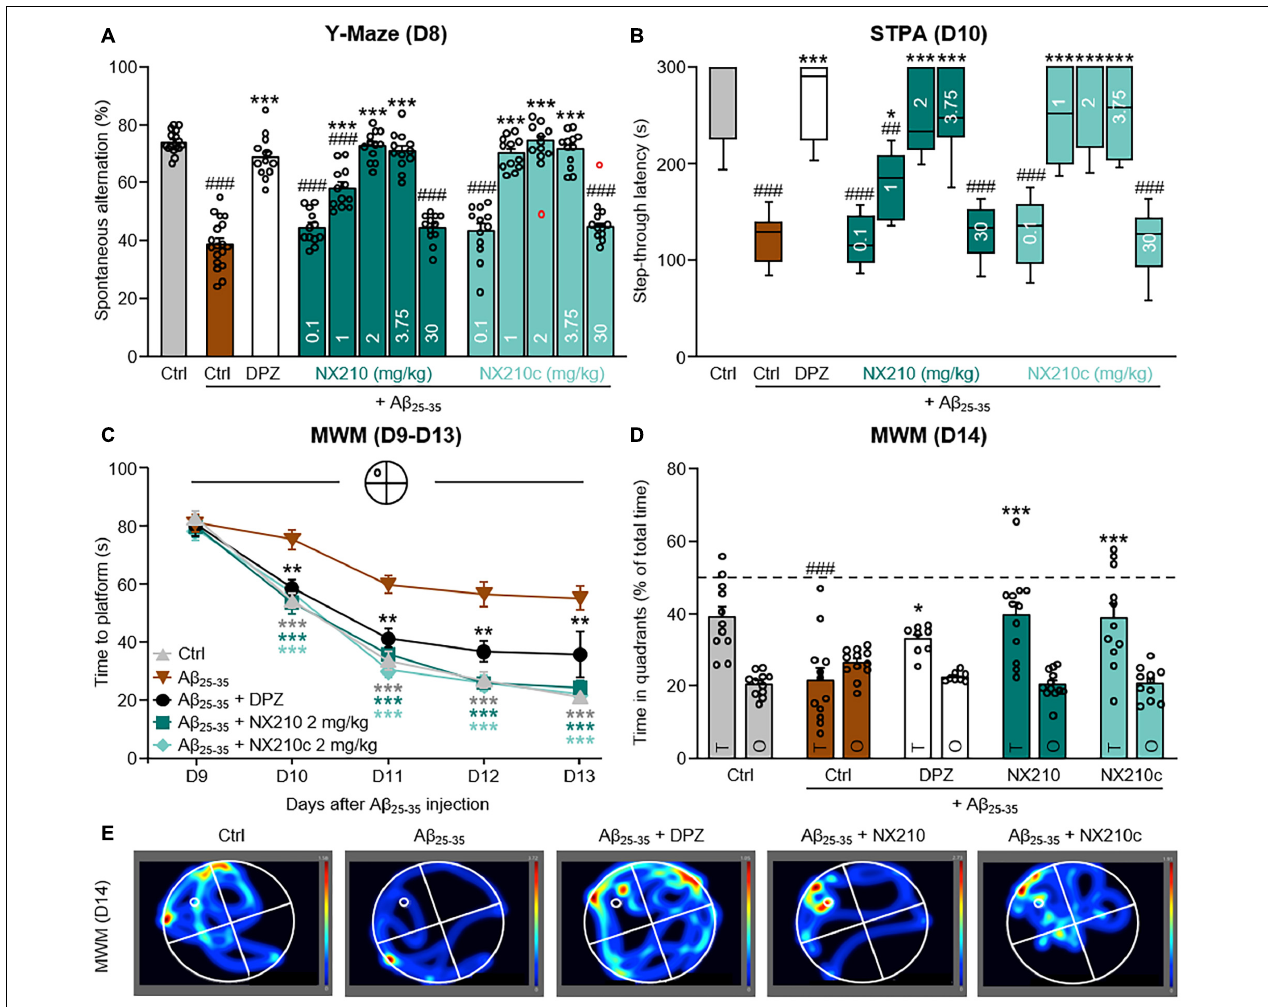
FIGURE 1 | Early stage daily treatment with NX210 or NX210c prevents amyloid-beta 25 - 35 (A β 25 - 35 )-induced short-term cognitive impairments in mice. Mice were treated intraperitoneally once a day with vehicle, NX210 or NX210c (0.1, 1, 2, 3.75, 30 mg/kg), or orally with donepezil (DPZ, 1 mg/kg) one hour after intracerebroventricular injection of scrambled control peptides (Ctrl) or A β 25 - 35 oligomers. They were subjected to several behavioral tests to evaluate learning and memory. (A) Early stage daily treatment with NX210 and NX210c restored working memory deficit in a dose-dependent manner, as shown by the increased number of spontaneous alternations in the Y-maze assessed at day 8 (D8) compared with A β 25 - 35 -injected mice treated with vehicle. The data are presented as means and SEM. One-way ANOVA followed by Tukey’s multiple comparisons test: ### p < 0.001 compared with Ctrl; *** p < 0.001 compared with A β 25 - 35 , n = 16 Ctrl, n = 18 A β 25 - 35 , n = 11–12 A β 25 - 35 + DPZ, A β 25 - 35 + NX210, A β 25 - 35 + NX210c. (B) Early stage daily treatment with NX210 and NX210c restored contextual long-term memory deficit in a dose-dependent manner, as shown by the increased time to enter the dark compartment in the step-through passive avoidance test performed at D10 compared with A β 25 - 35 -injected mice treated with vehicle. The data are presented as medians and interquartile range. Kruskal–Wallis followed by Dunn’s test: ### p < 0.001, ## p < 0.01 compared with Ctrl; *** p < 0.001, * p < 0.05 compared with A β 25 - 35 , n = 16 Ctrl, n = 18 A β 25 - 35 , n = 11–12 A β 25 - 35 + DPZ, A β 25 - 35 + NX210, A β 25 - 35 + NX210c. (A,B) These analyses do not include two outliers identified for the Y-Maze using the Grubbs test (red circles) ( p < 0.05). (C–E) Morris water maze test was performed from D9 to D14 to assess spatial learning (C) and retention memory (D,E) of mice treated with vehicle, NX210 or NX210c